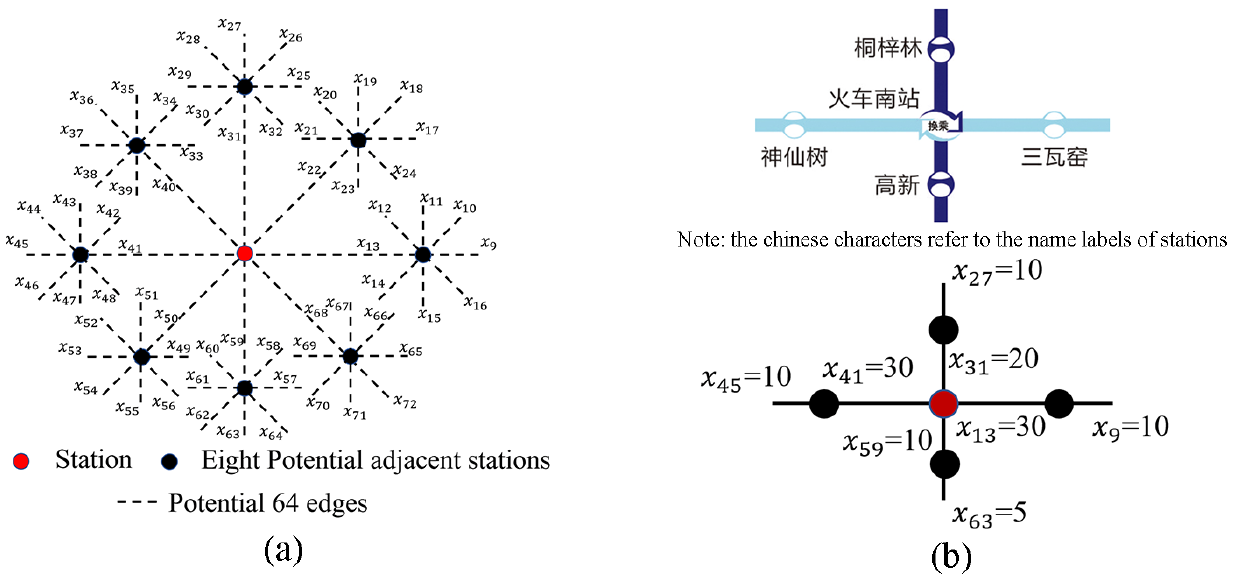
Figure 5. Connection relations between adjacent stations and edges: ( a ) 64 variables for coding connection relations between adjacent stations and edges and ( b ) an example of such connection relations.